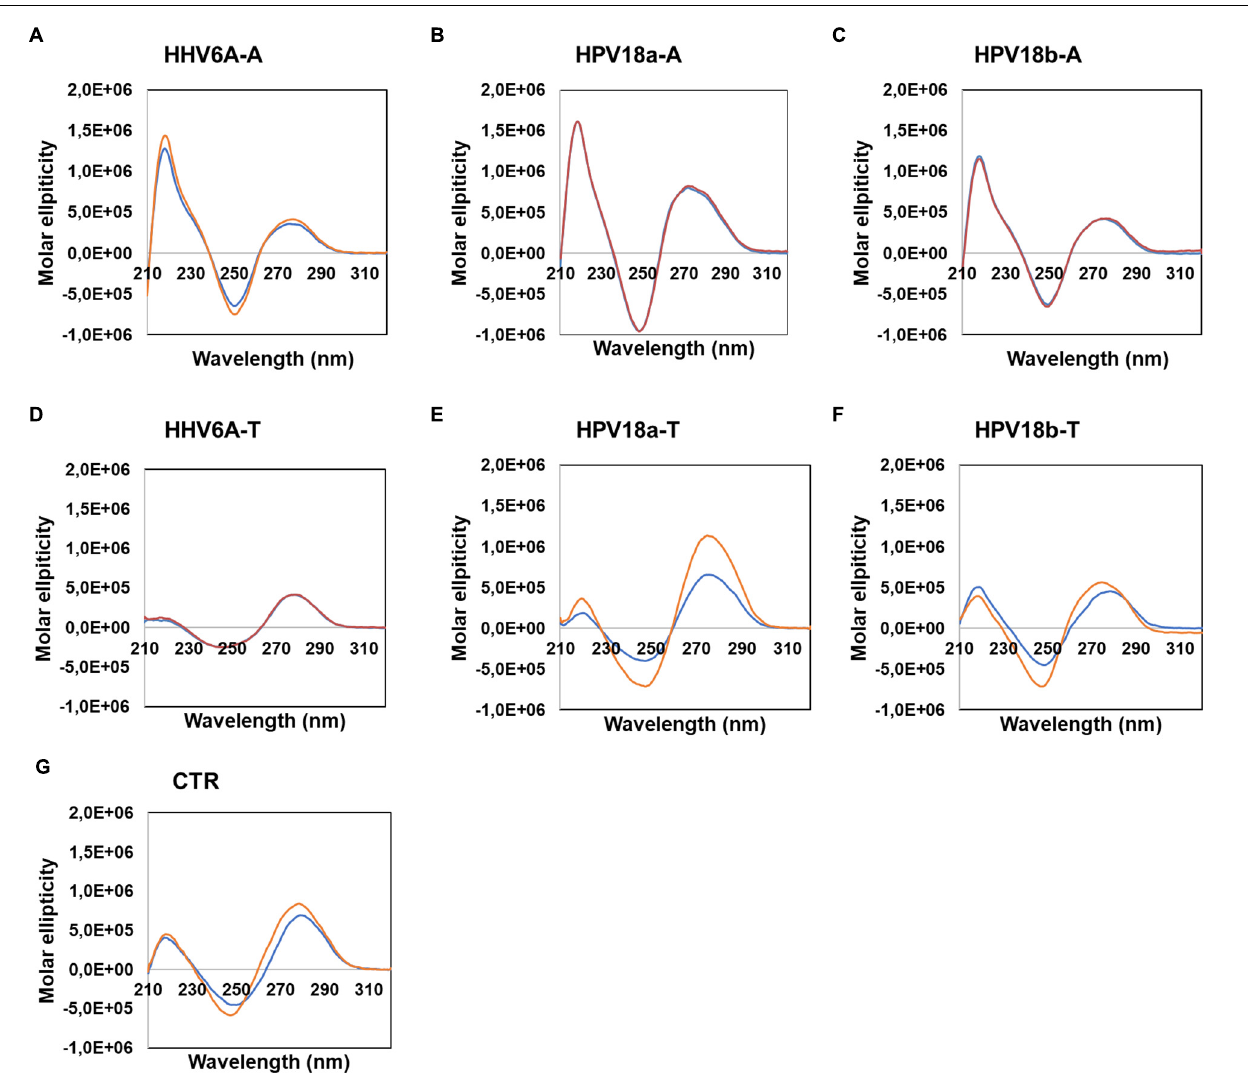
FIGURE 4 | Circular dichroism analysis of HHV6A-A (A) , HPV18b-A (B) , and HPV-18b-A (C) , and respective complementary T-rich sequences (D–F) . Samples were prepared in the absence (blue line) or presence (red line) of 100 mM KCl. The CTR sequence (G) was used as a control for unstructured DNA. Analysis was performed at 20 ◦